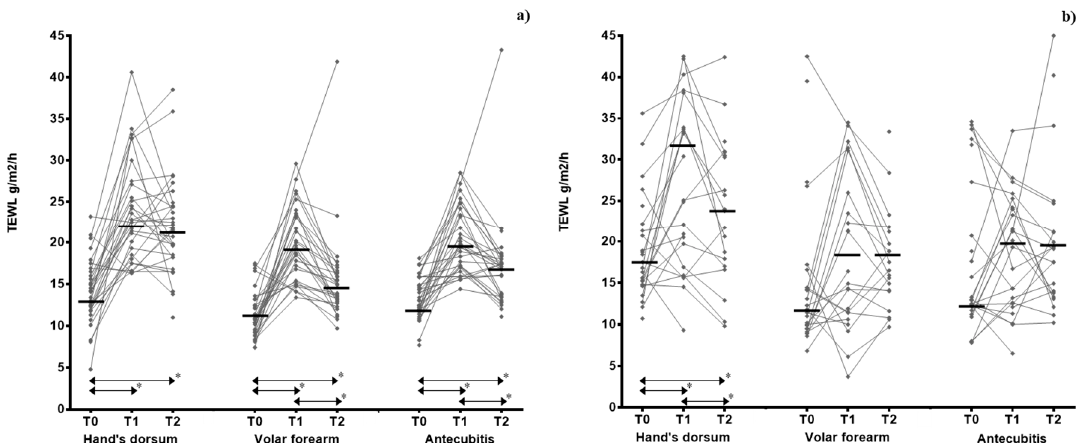
Figure 1. Variation of transepidermal water loss measurements by swimmers ( a ) and football players ( b ), body location, and stages of evaluation. T0—before training, T1—immediately after training, T2—30 min after training with an acclimatization period of 15 min allowed before each measurement. * significant differences ( p < 0.05).